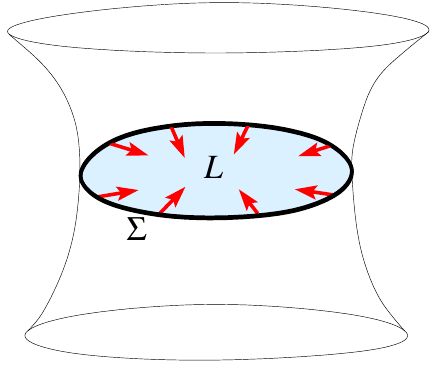
Figure 2 . An illustration of the anomaly in(cid:13)ow from the boundary into the bulk of the D4-brane world-volume theory.